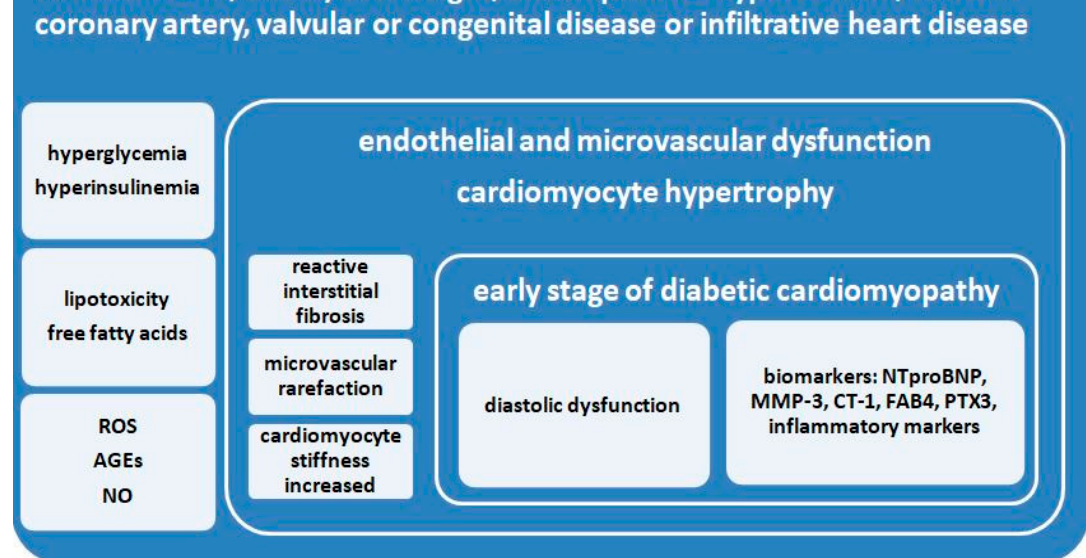
Figure 2. The pathways of left ventricular diastolic dysfunction in diabetic patients. AGEs: advanced glycation end-products; CT-1: cardiotrophin-1; FAB4: fatty acid-binding protein 4; MMP-3: matrix metalloproteinase-3; NO: nitric oxide; NTproBNP: N-terminal pro brain natriuretic peptide; PTX3: pentraxin-3; ROS: reactive species of oxygen.